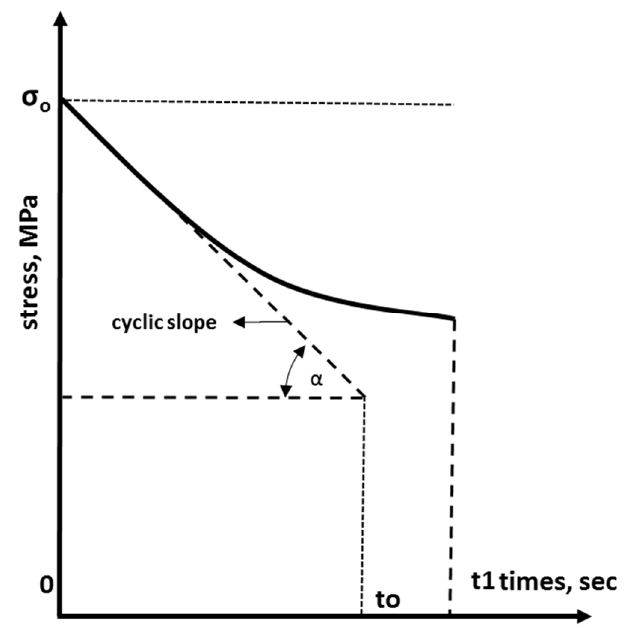
Figure 7. Experimental cyclic slope.